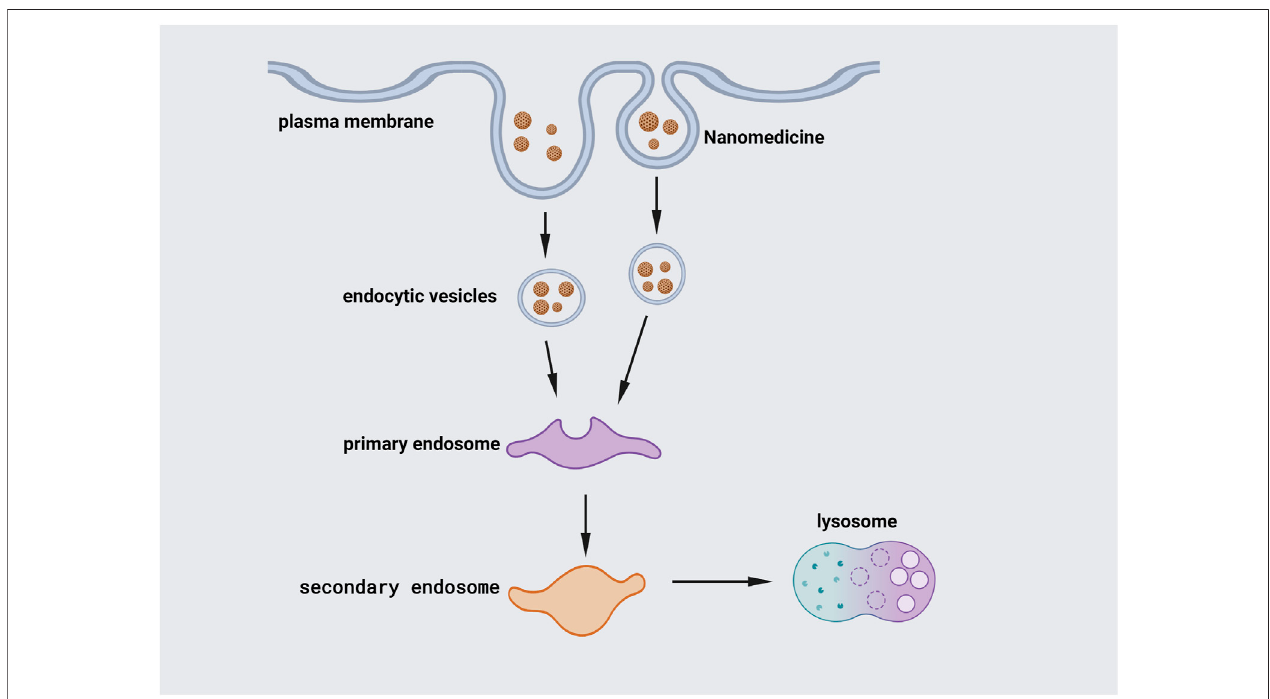
FIGURE4| Internalization ofNPs.Endocytosis, the majorchannel forpassing thecellular membrane,allows NPstoenterthe cell.Larger particlescanbetakenup by phagocytosis. The cell membrane engulfs the NPs, trapping them in the cellular vesicle. The vesicles are then uncoated and sent to intracellular components with speci fi c functions. Early endosomes join vesicles together and shuttle particles to various locations. After that, the early endosome grows into the late endosome, which fuses with lysosomes.